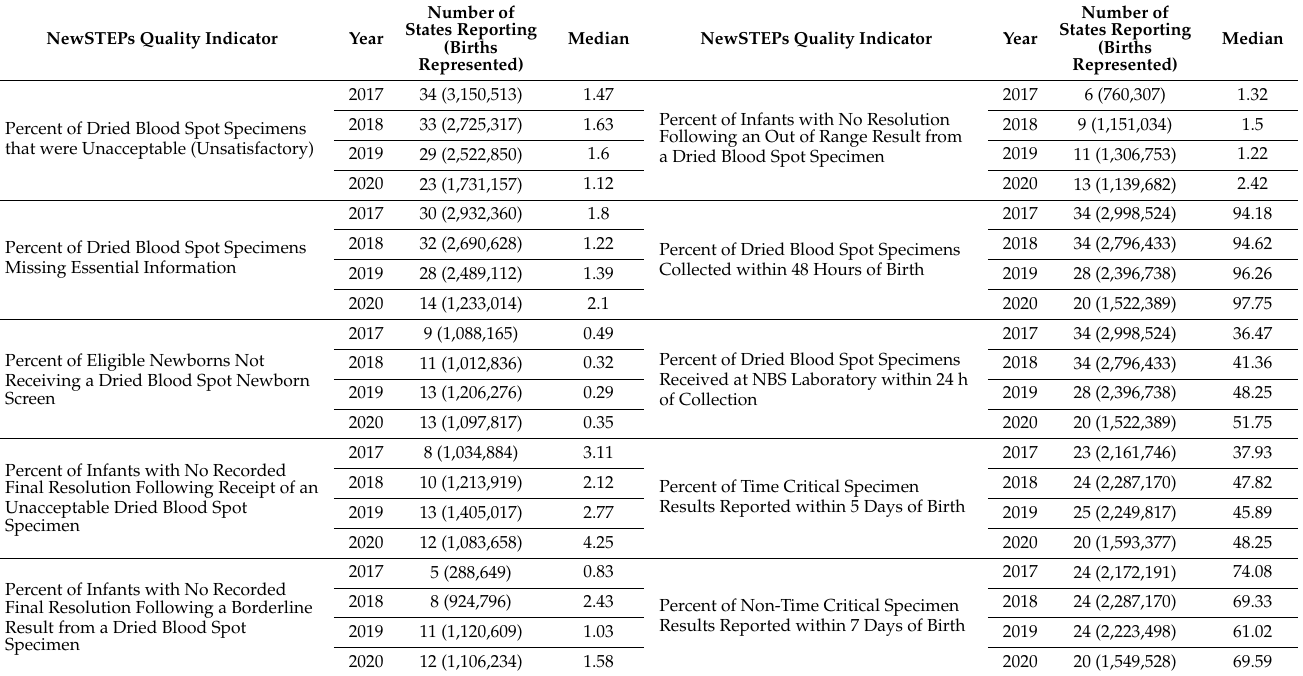
Table 3. NewSTEPs quality indicator data national summary,